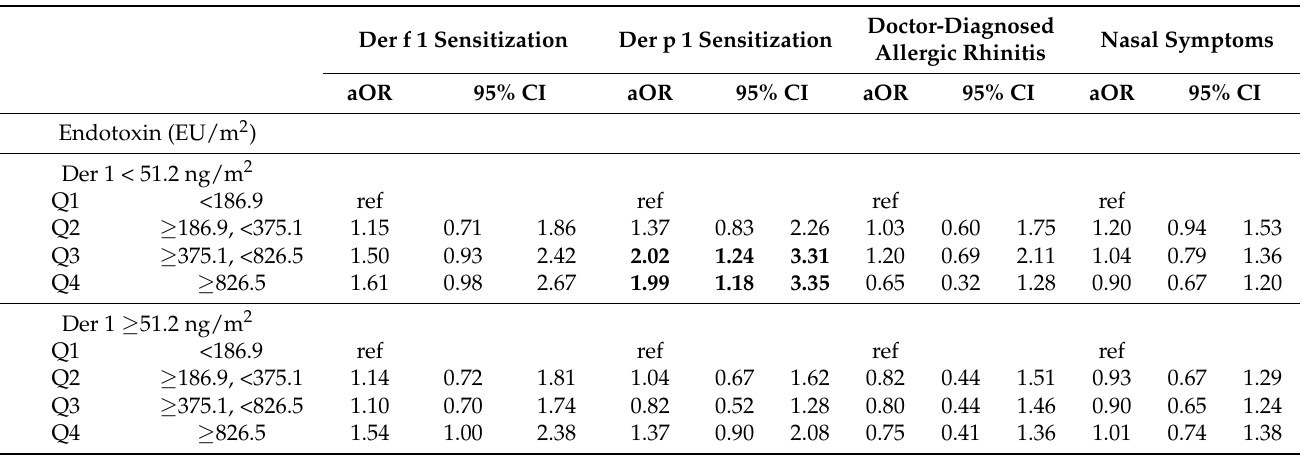
Table 4. Odds ratios of sensitization to Der 1 and allergic rhinitis in relation to endotoxin exposure in the Der 1 status